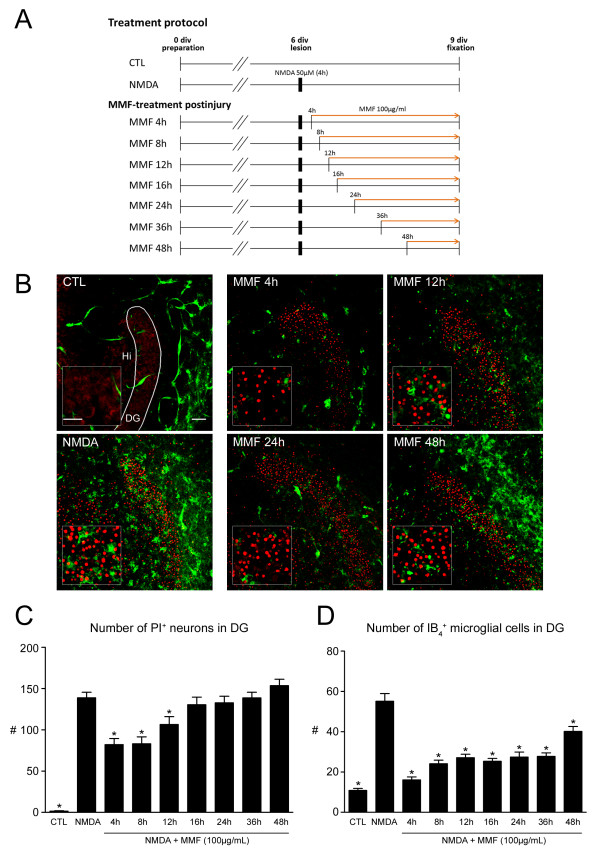
Effects of continuous mycophenolate mofetil (MMF) treatment from different time points after injury on neuronal survival and microglial activation in organotypic hippocampal slice cultures (OHSCs).(A) Treatment protocols. (B) Confocal laser scanning microscopy images in overview and higher magnification, double-labeled with propidium iodide (PI) (degenerating neurons, red) and IB4 (microglial cells, green). Untreated control (CTL) OHSCs had very good preservation of the hippocampal formation with almost no PI+ pyknotic nuclei and only a few ramified IB4+ microglial cells. Slices treated with NMDA 50 μmol/l for 4 hours had massive accumulation of amoeboid IB4+ microglial cells and a dramatic increase in PI+ neuronal nuclei. Delayed treatment (until 12 hours after injury) with MMF resulted in a significant reduction of PI+ degenerating neurons. Numbers of microglial cells were reduced even with late administration of MMF (after 48 hours post-injury). (C-D) Quantitative analyses of the effects of MMF on NMDA-lesioned OHSCs. The mean numbers of (C) PI+ degenerating neurons and (D) IB4+ microglial cells were calculated for each experimental group and compared with OHSCs treated with NMDA alone (*P < 0.05 vs. NMDA). DG, dentate gyrus; Hi, hilus. Scale bars = 50 μm in overviews; 20 μm in insets